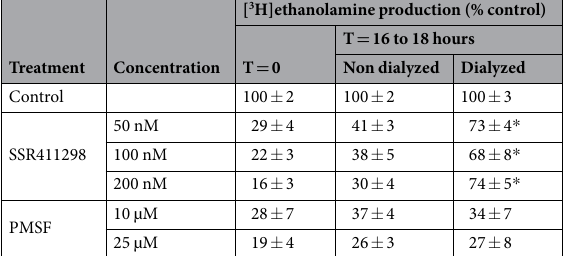
Table 1. Study of the reversibility by dialysis of the effects of SSR411298 and PMSF on mouse brain FAAH activity. Mouse brain homogenates were incubated 30 minutes at 25 °C without (control) or with SSR411298 or PMSF. FAAH activity, estimated by [ 3 H]ethanolamine production, was measured immediately after incubation (T = 0) and after 16 to 18 hours at 25 °C without (non dialyzed) or with dialysis (dialyzed). Data expressed as the percent of mean of control values, are the mean ± SEM of 3 to 4 independent experiments corresponding to